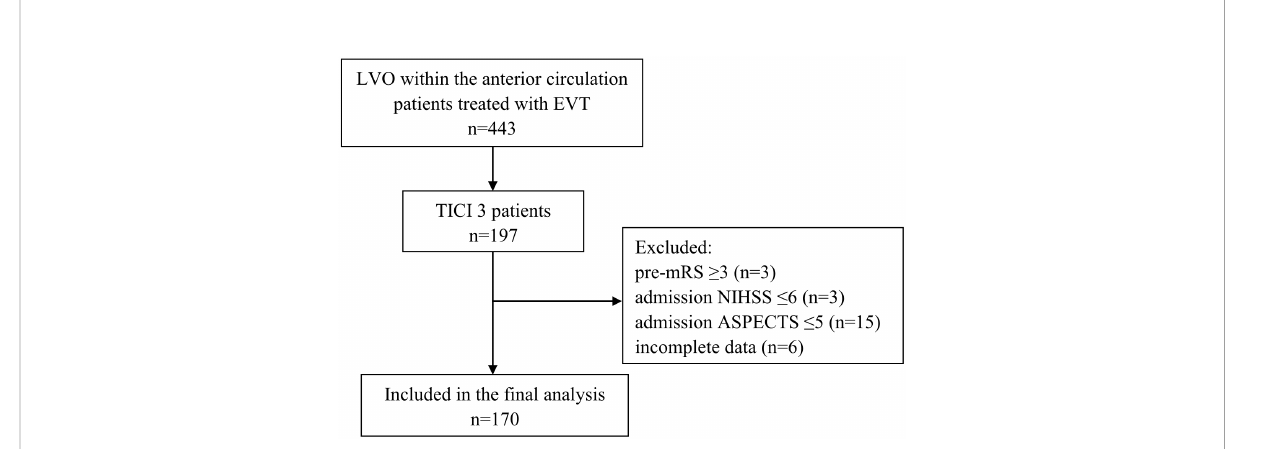
FIGURE 1 Flow chart demonstrating the number (n) of patients included in the analysis. ASPECTS, Alberta Stroke Program Early CT Score; LVO, large vessel occlusion; mRS, modi fi ed Rankin scale; EVT, endovascular treatment; NIHSS, National Institutes of Health Stroke Scale; TICI, Thrombolysis in Cerebral